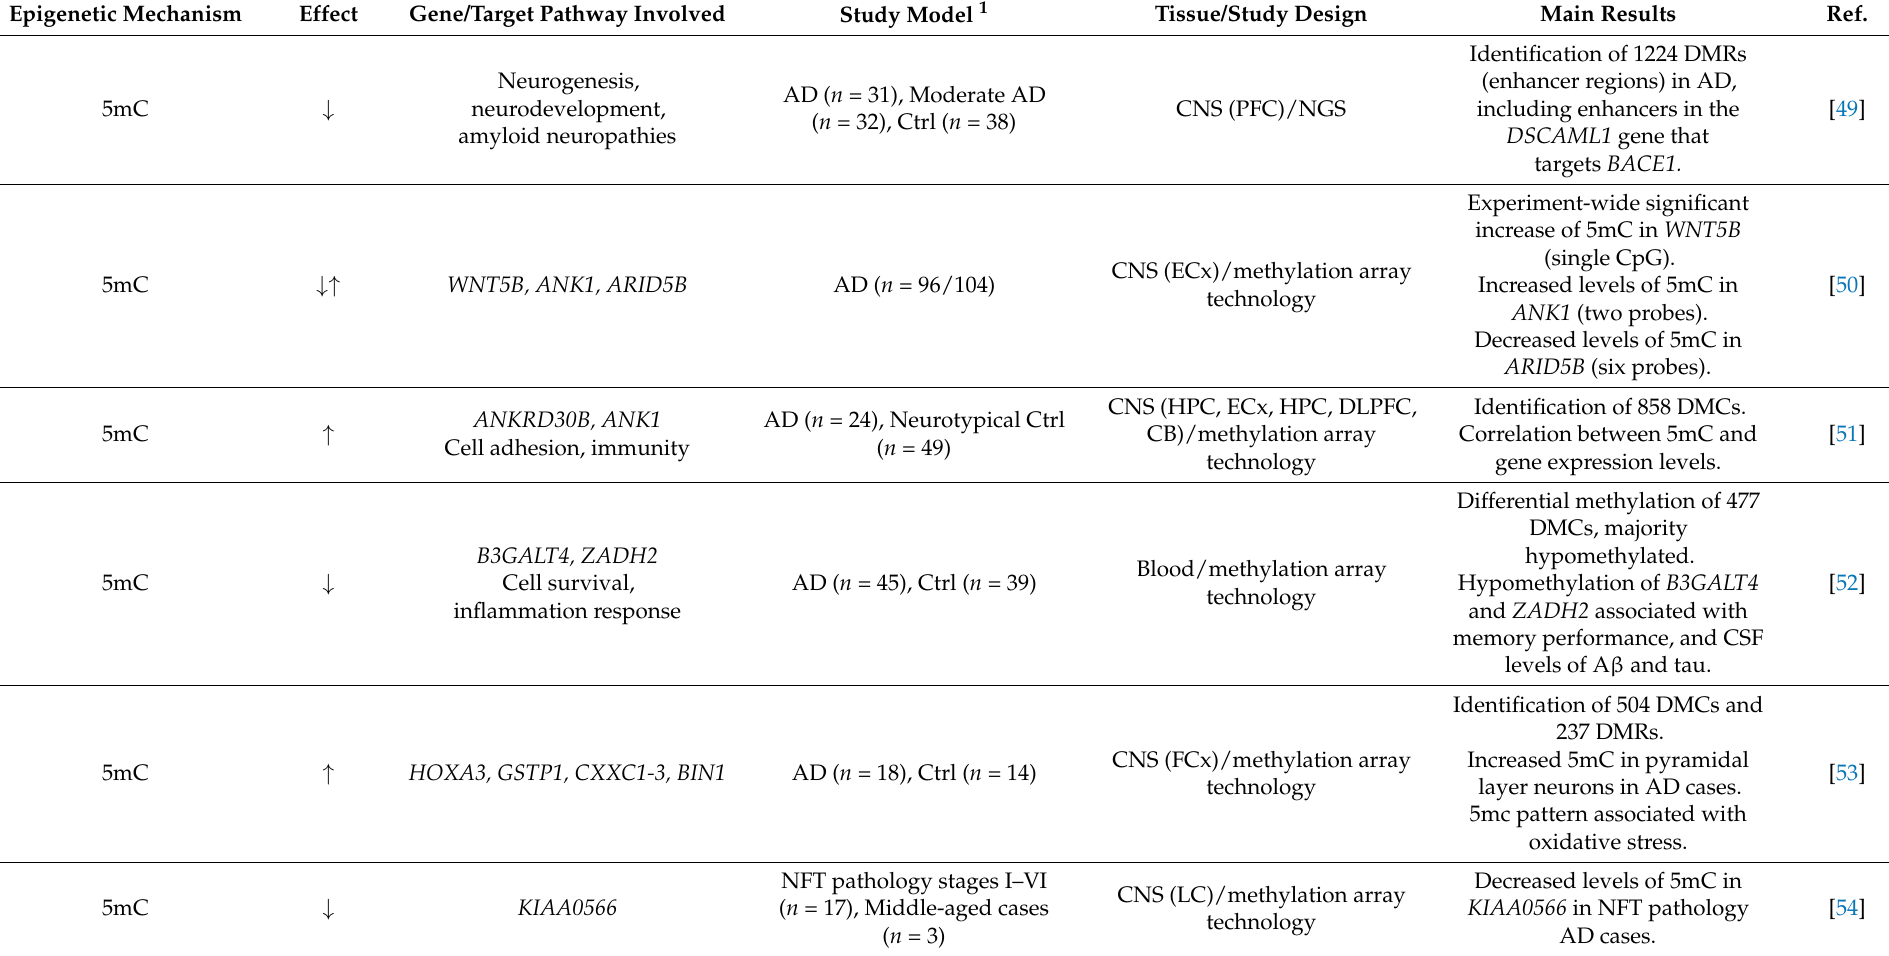
Table 1. Overview of studies investigating genome-wide DNA methylation in